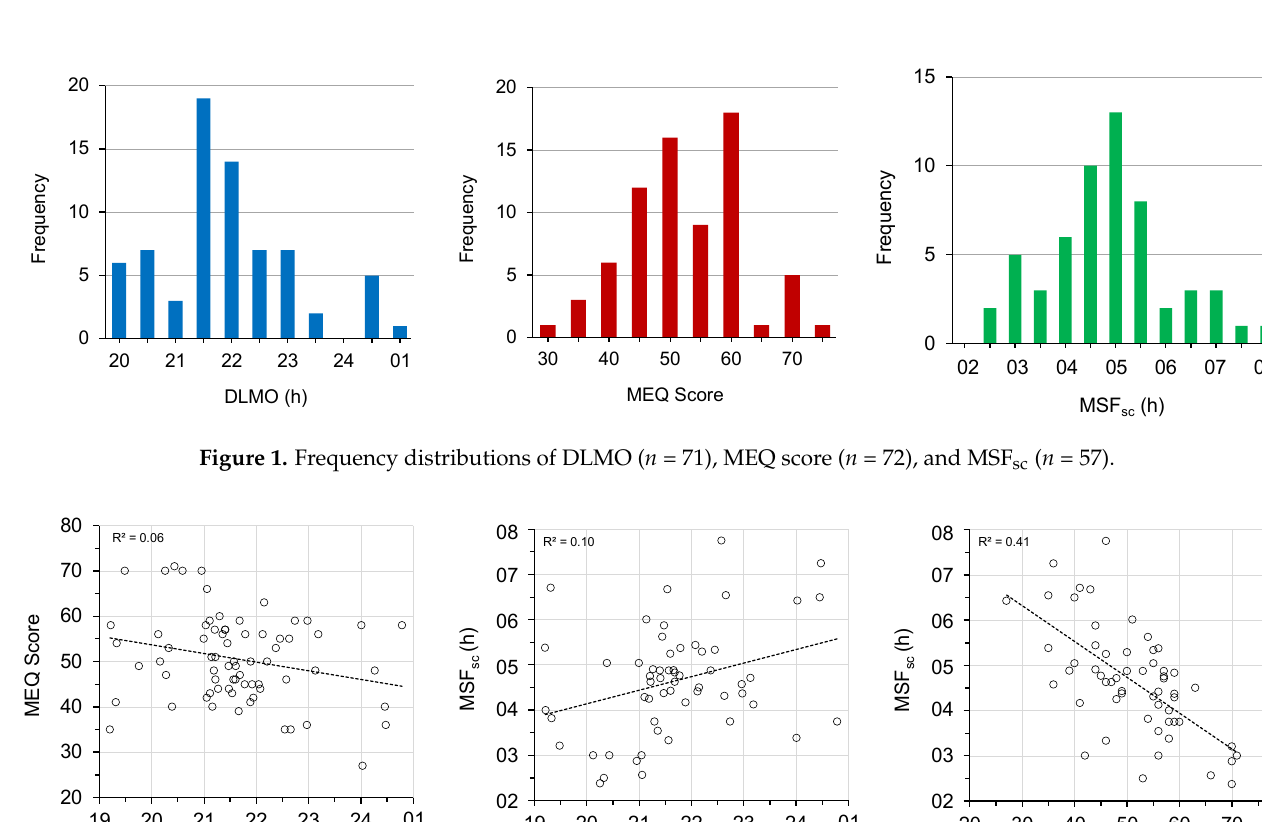
Figure 2. Scatter plots of MEQ score versus DLMO ( n = 71), MSF sc versus DLMO ( n = 57), and MSF sc versus MEQ score ( n = 57).